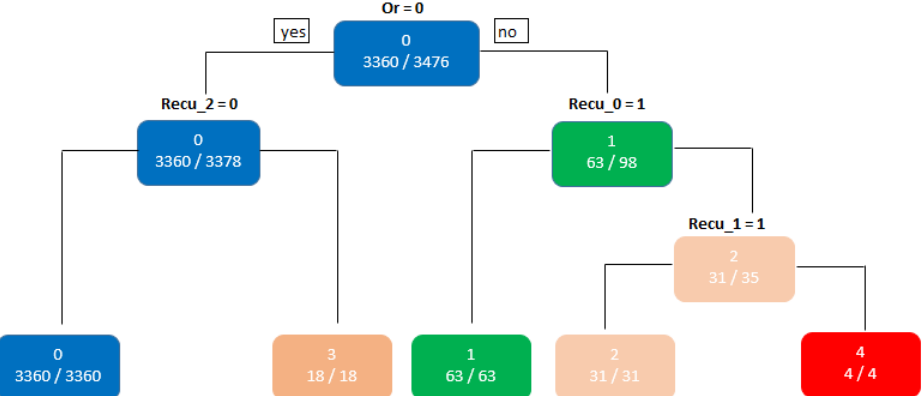
Figure 6. Graphical representation of the resulting classification tree. The tree has three levels of depth and five decision rules and determines different levels of severity.